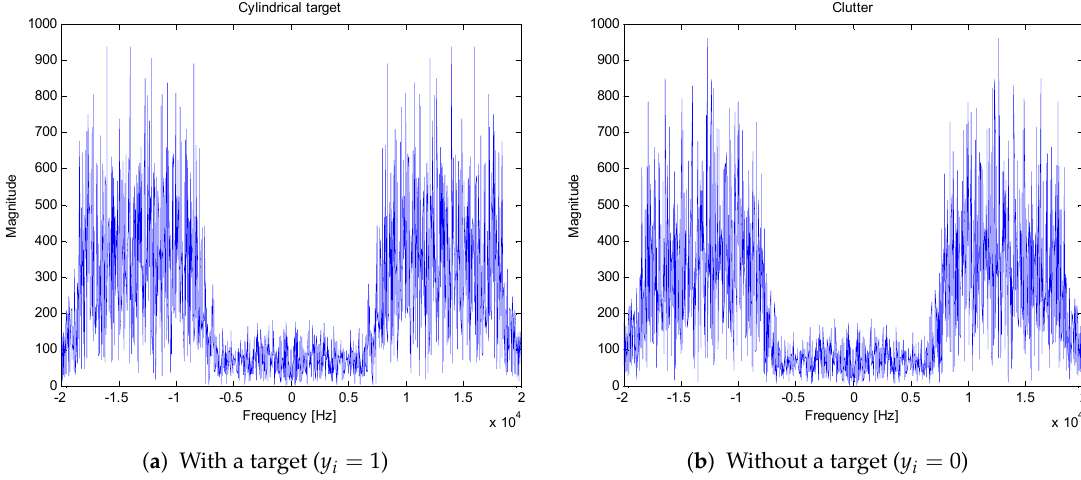
Figure 7. Magnitude spectra of the match-filtered received signals with and without a